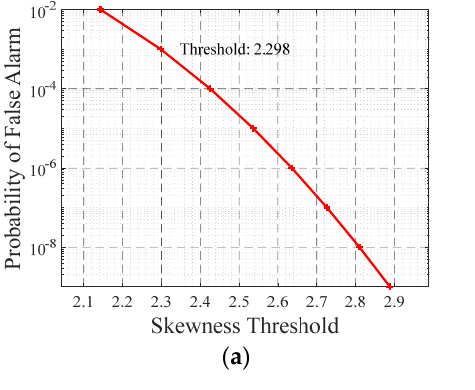
Figure 13. RFI detection results of the measured SAR data corrupted with simulated RFI: ( a ) the variation of optimal threshold with different false alarm levels. ( b ) the RFI detection result at a false alarm rate of 10 − 3